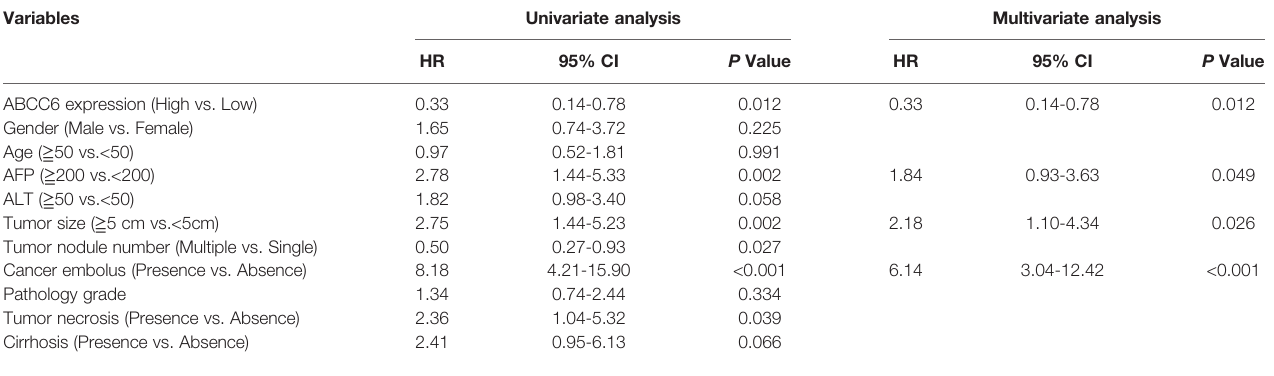
TABLE 3 | Cox regression analysis of risk factors associated with overall survival in Renji Hospital hepatectomy cohort. Variables Univariate analysis Multivariate analysis HR 95% CI P Value P Value ABCC6 expression (High vs.